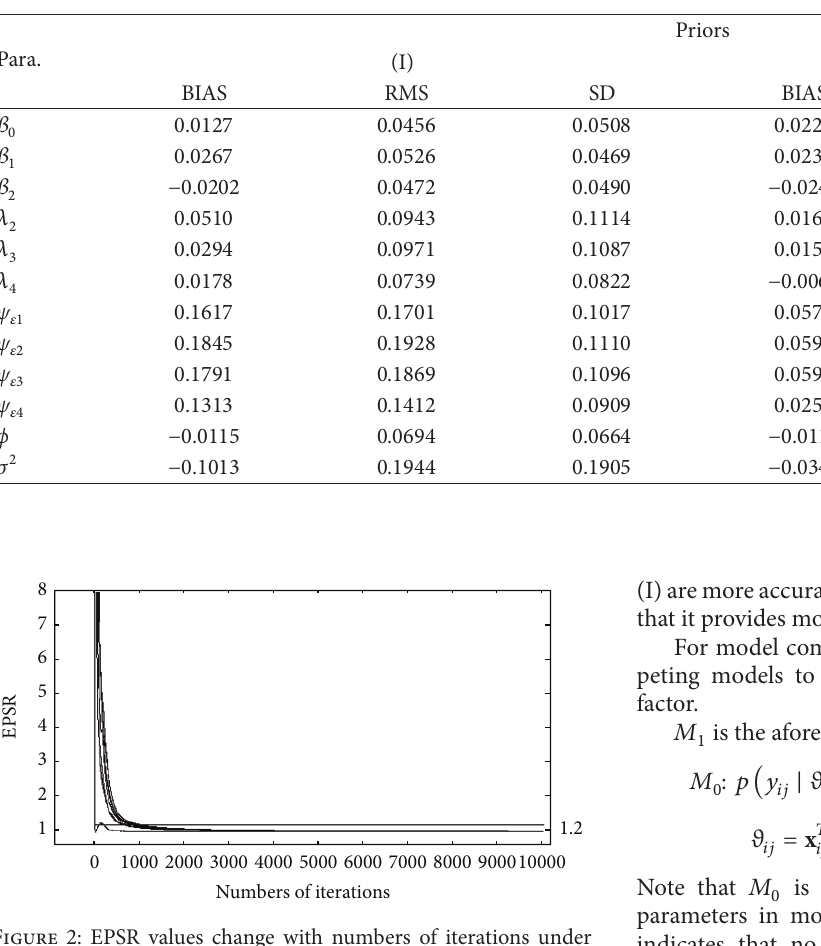
Figure 2: EPSR values change with numbers of iterations under prior